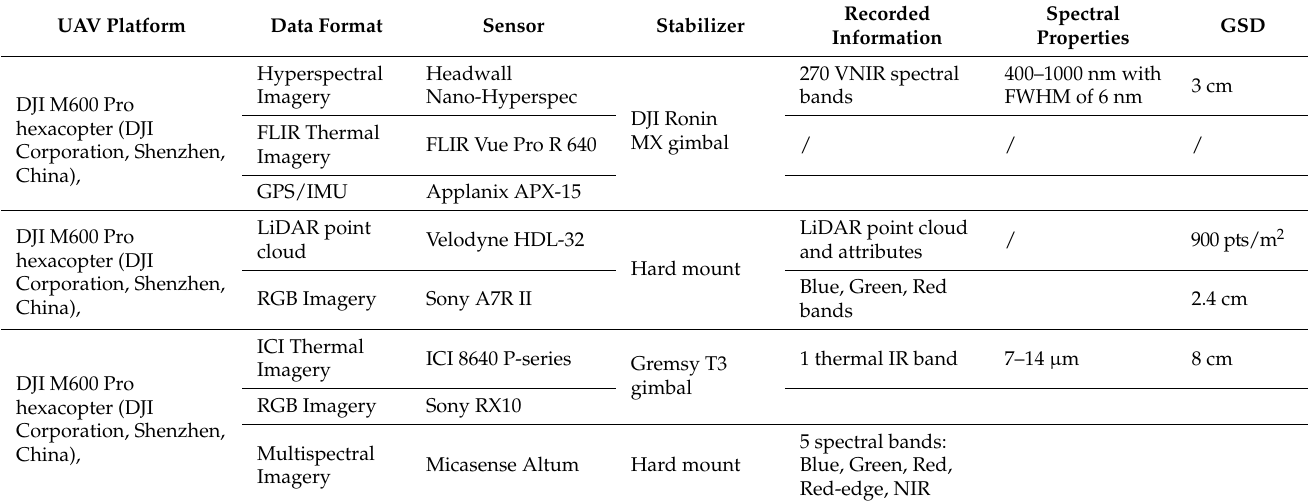
Table 2. A summary of UAV platforms with multiple aerial remote sensors and